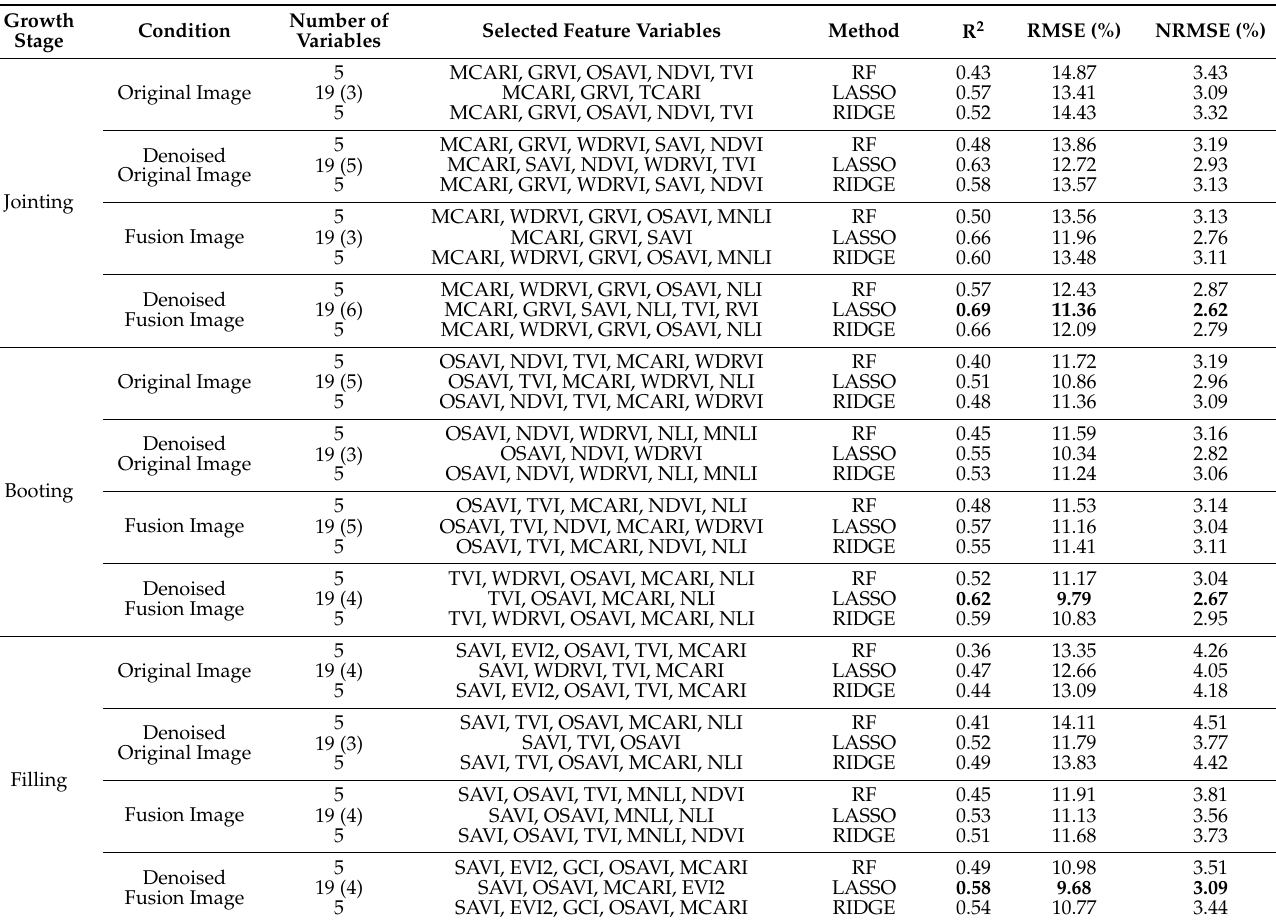
Table 5. Predictive performance of LNC using the RF, LASSO and RIDGE algorithms for both the original and fusion images and the corresponding denoised